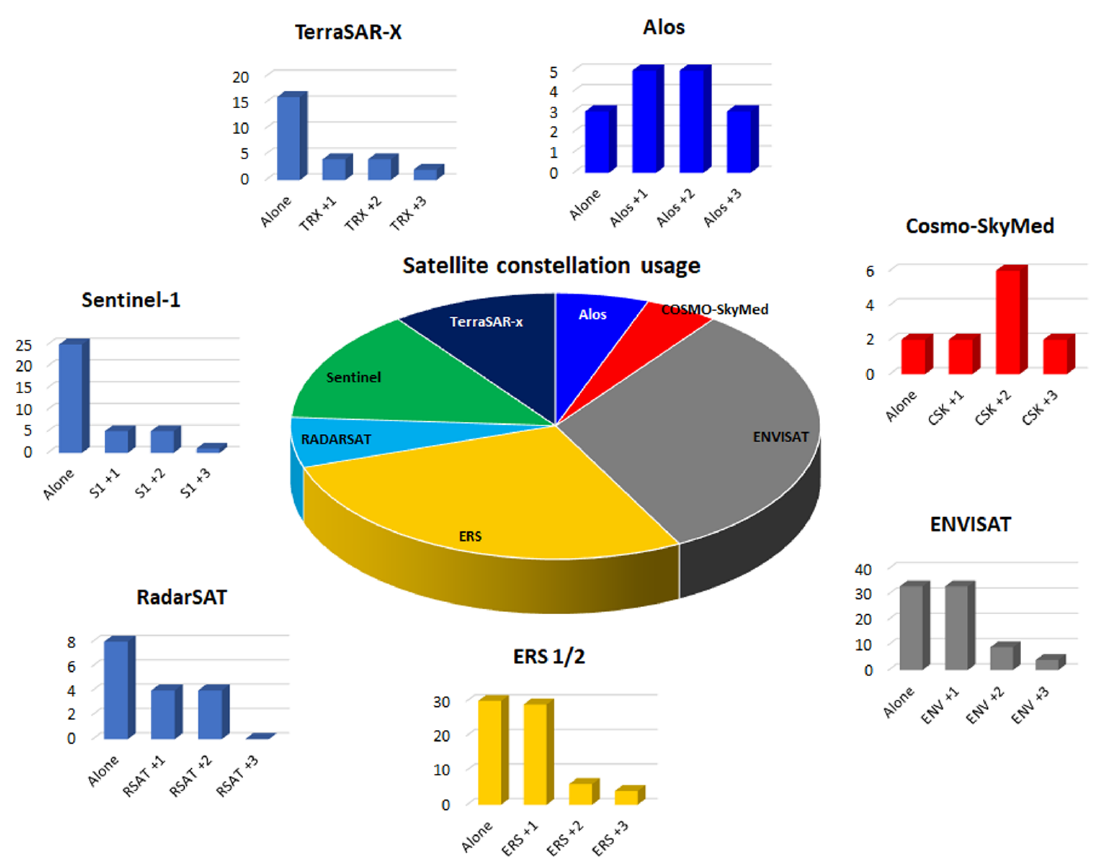
Figure 5. Satellite constellation usage considering all the applicative scientific contributions (center) and a more detailed analysis of the use of the dataset of a single satellite (Alone) or with another satellite (+1), with other 2 (+2) or three (+3) constellations (satellite graphs).